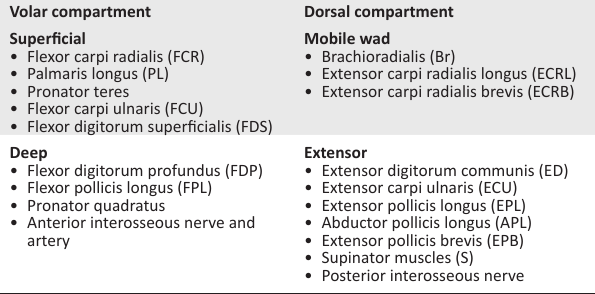
FIGURE 2: Cross-sectional diagram of the mid forearm delineating the compartments of the volar and dorsal forearm: (1) Brachioradialis; (2) Flexor carpi radialis (FCR); (3) Palmaris longus; (4) Flexor digitorum superficialis; (5) Flexor carpi ulnaris; (6) Flexor digitorum profundus (FDP); (7) Flexor pollicis longus (FPL); (8) Extensor carpi radialis longus; (9) Extensor carpi radialis brevis; (10) APL; (11) Extensor pollicis brevis; (12) Extensor pollicis longus (EPL); (13) Extensor digitorum communis (ED); (14) Extensor digiti minimi; (15) Extensor carpi ulnaris; (16) Radius; (17)